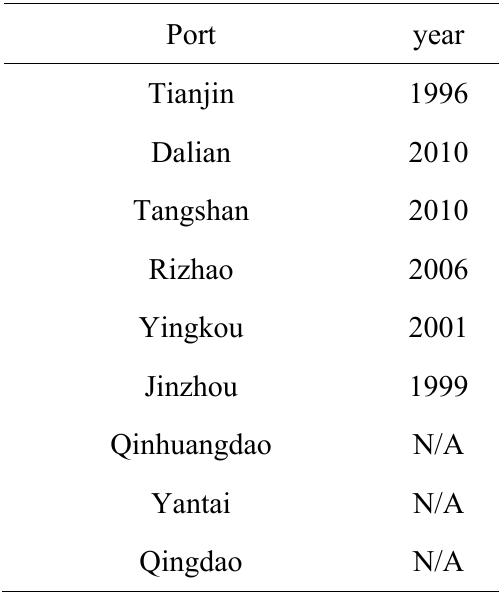
Table 1. Time of